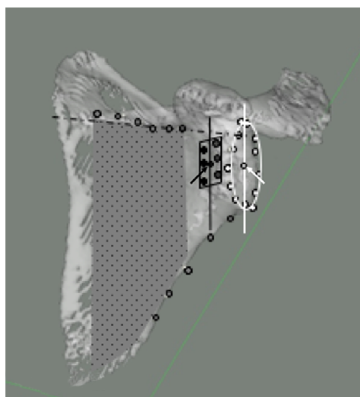
Figure 2. 3D reconstruction of a scapula specimen showing the various radiological reference planes. GR plane (represented by the oval shape with white border) of points placed at the edge of the articular surface (White ROI points with black contour), GR centre (white arrow), and GR superior-inferior axis (white line). B plane (Grey doted area) formed by points (Grey ROI points with black contour) placed on the spine root pf the scapula (dotted line) and on the lateral border of the scapula. New GvOC plane (represented by the black rectangle) formed by points (Black ROI points) on the six described GvOC ROI landmarks, with best fi t centre (Black arrow) and superior-inferior direction (Black